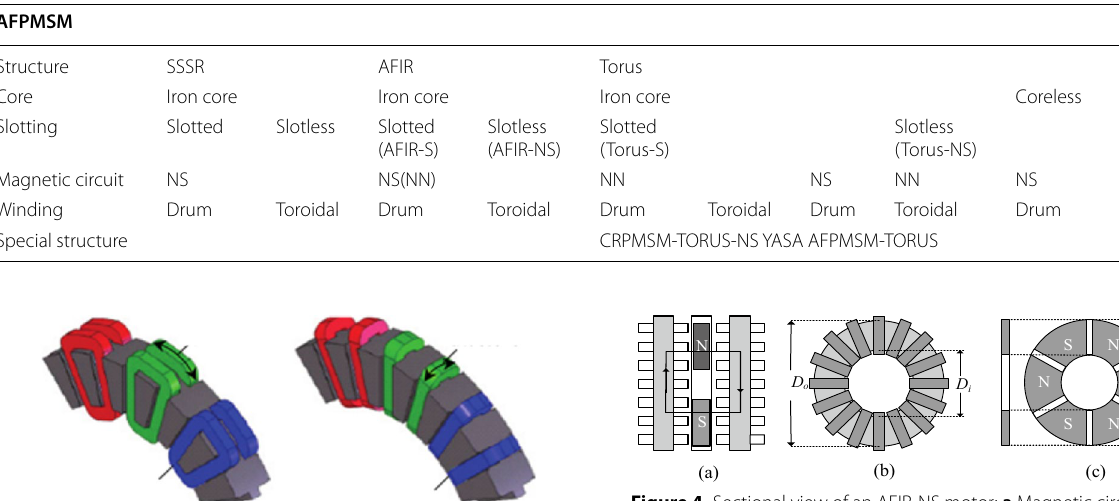
Table 1 Classification of AFPMSMs